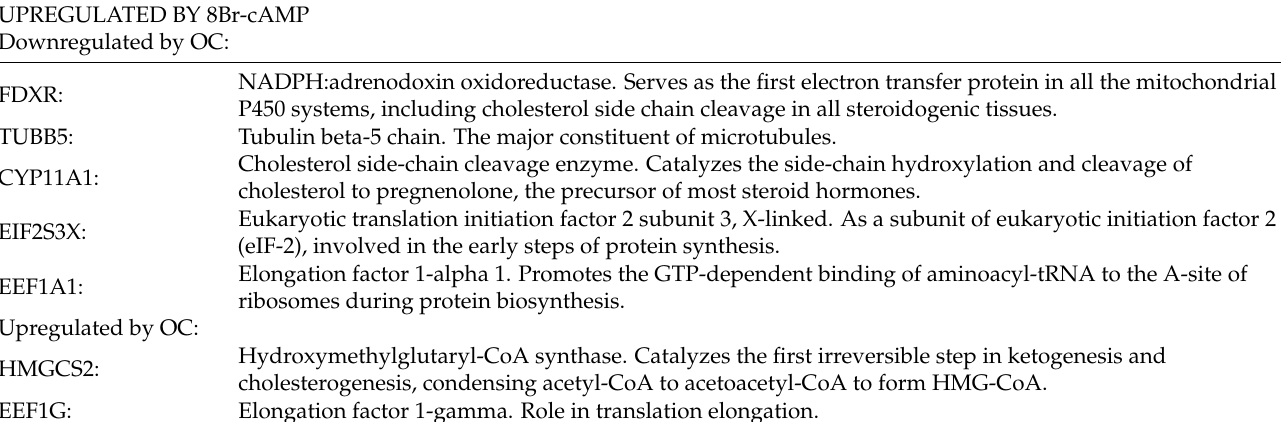
Table 7. Main function of proteins identified in Sample 2 and modulated by the OC mixture (Figure